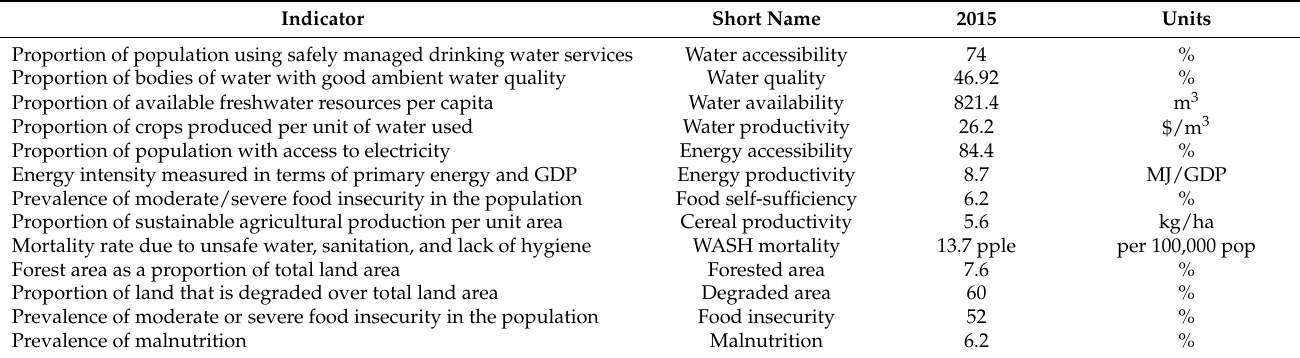
Table 2. Overview of the WEF nexus indicators for South